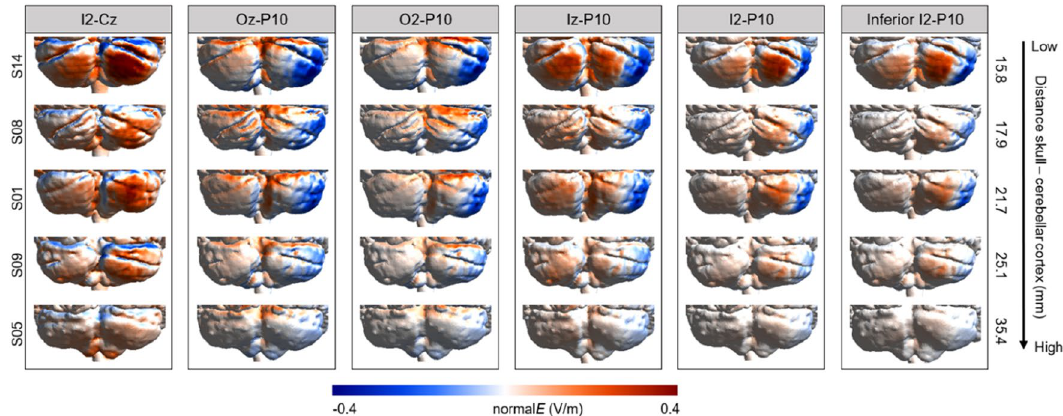
Figure 7. Field direction (normalE in V/m) for the six alternative electrode montages. Individual electric fields are depicted for five individuals representative of the range of scalp–cortex distance. Positive values (red) refer to current inflow and negative values (blue) refer to current outflow. An illustration of individual field directions of all individuals included in the study can be found in the “Supplementary Materials” (Fig.